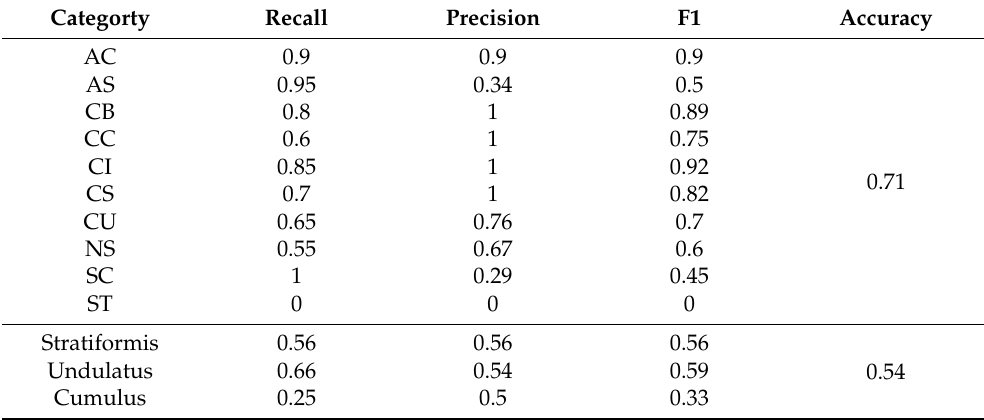
Table 5. Performance evaluation of Canny datasets with multiple classification